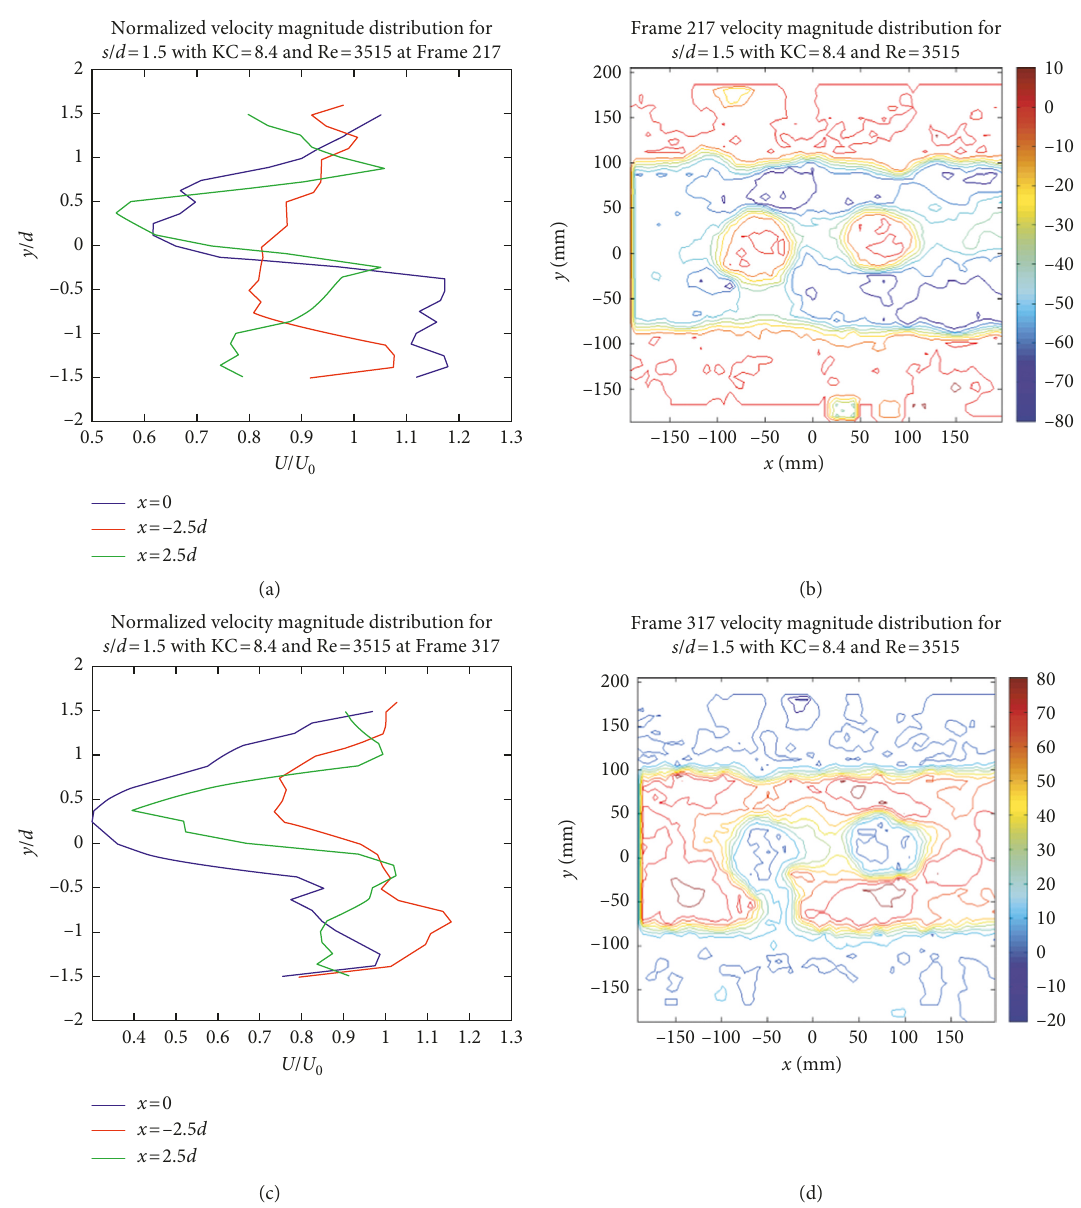
Figure 9: Normalized velocity and velocity contour when s/d � 1.5, Re � 3515.5, and KC � 8.4; (a) normalized velocity at Frame 217; (b) velocity magnitude contour at Frame 217; (c) normalized velocity at Frame 317; (d) velocity magnitude contour at Frame